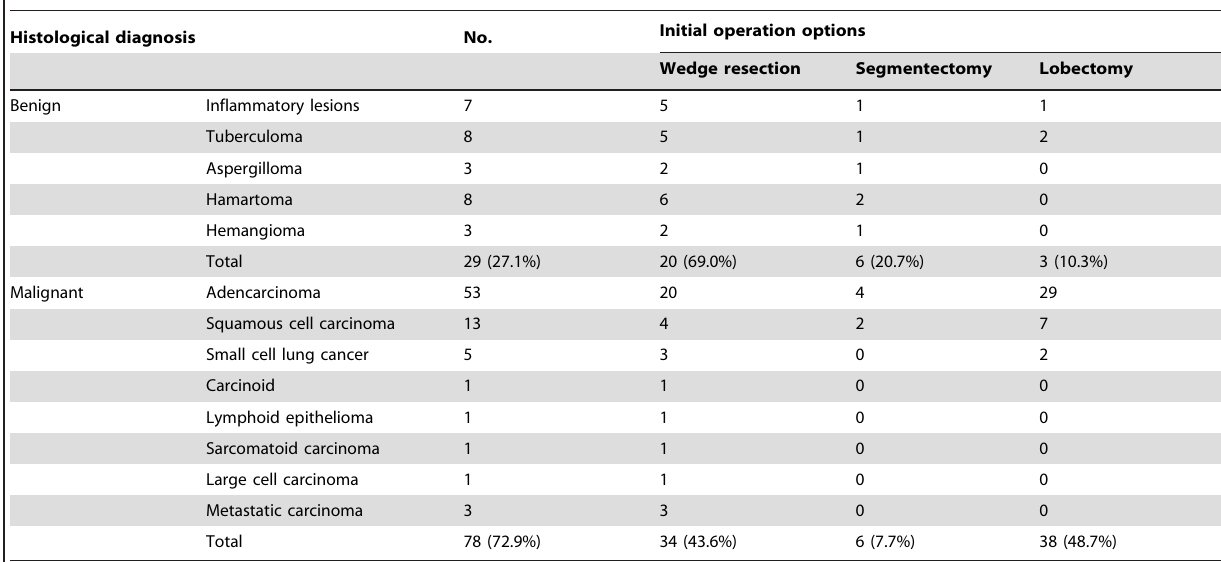
Table 2. Histological diagnosis and initial operation options.